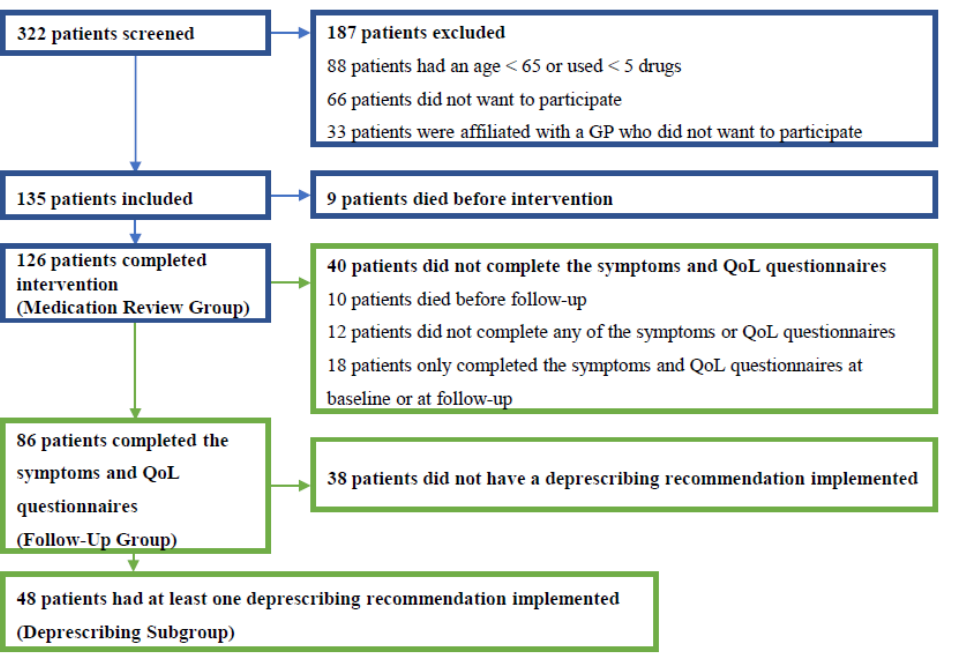
Figure 1. The flow of patients from screening to the inclusion of eligible patients in the Medication Review, Follow-Up, and Deprescribing Subgroup, respectively. The upper five boxes (blue) describe the inclusion process, as well as reasons for exclusion and dropout, whereas the lower four boxes (green) describe the subsets of patients relevant to the aim of this article, i.e., patients who completed the symptoms and quality of life (QoL) questionnaires both at baseline and follow-up were included in the Follow-Up Group. Subsequently, patients in the Follow-Up Group who had a deprescribing recommendation implemented were included in the Deprescribing Subgroup.